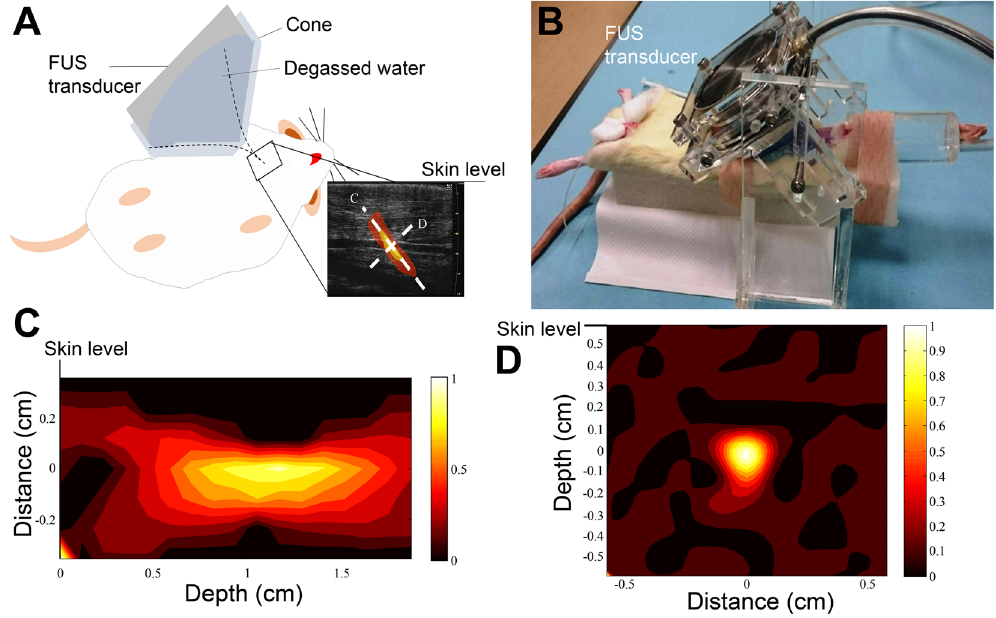
Figure 6. Design of focused ultrasound (FUS) exposure to left common carotid artery of rat. ( A ) Schema of the application of FUS in rat. ( B ) The actual picture of FUS application in rat. ( C and D ) The depth of FUS exposure below the skin